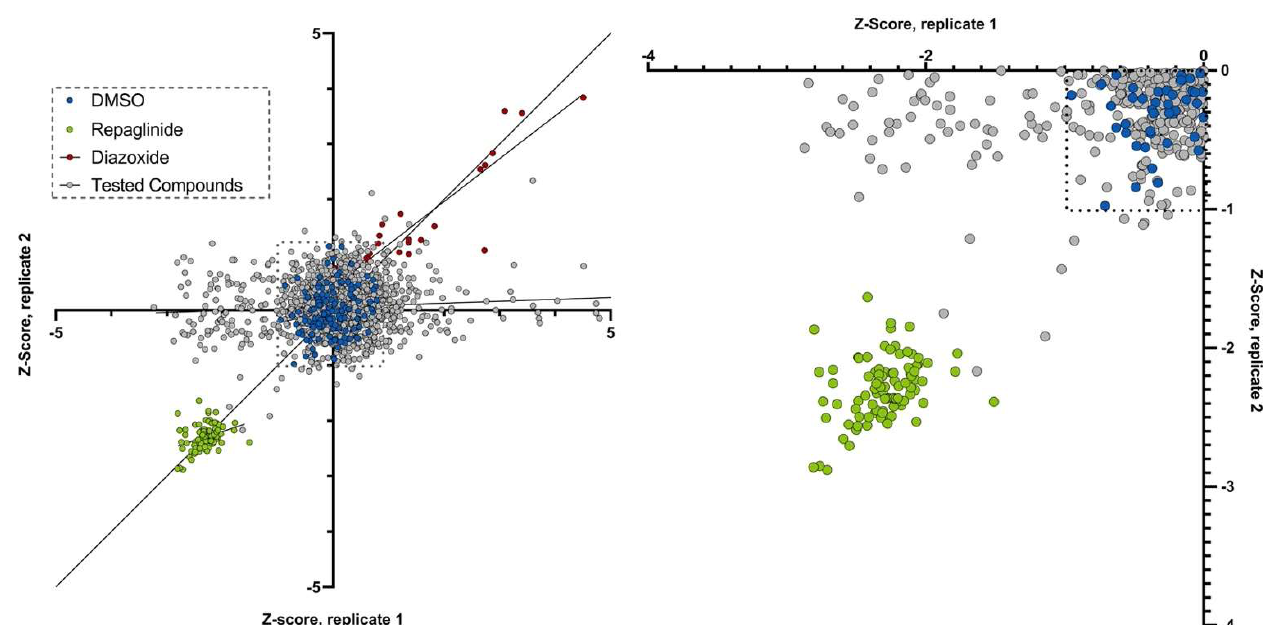
Figure 6. High-throughput chemical screen of Min6 cells identifies small molecules that may amplify insulin release and decrease insulin intracellular content after glucose stimulation. Min6 cells were treated with 1600 chemical compounds and insulin content was measured using MALDI-TOF mass spectrometry. Compounds from the chemical library are in grey. Repaglinide (green) was used as a positive control, whereas diazoxide (red) was used as an inhibitor of insulin secretion.